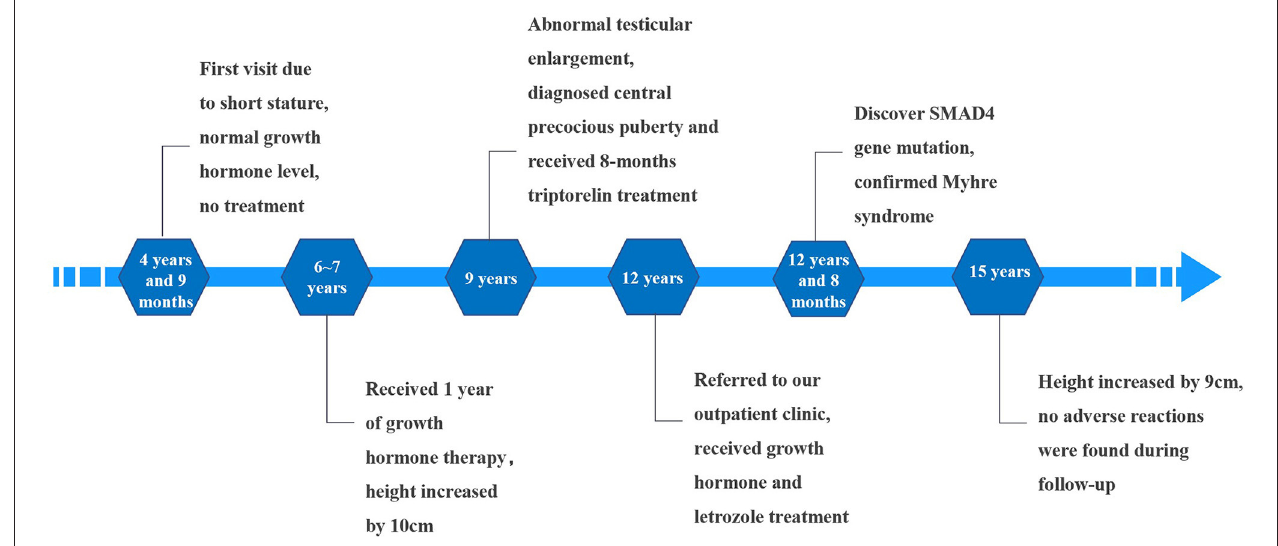
FIGURE 3 | Timeline of the patient’s treatment